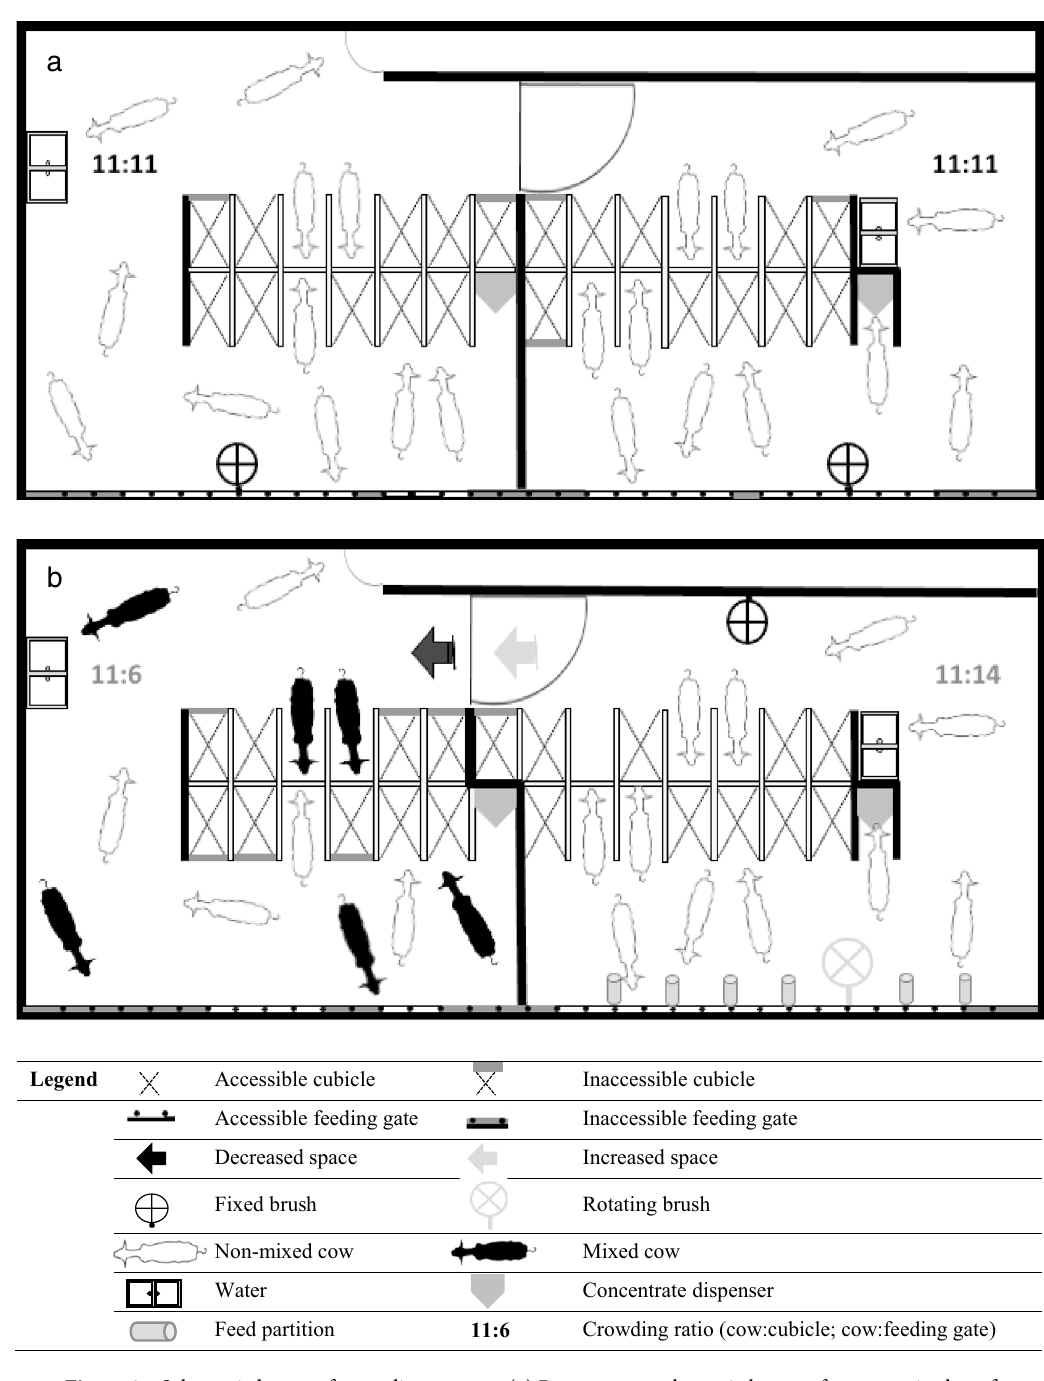
Figure 2. Schematic layout of two adjacent pens. ( a ) Represents a schematic layout of two pens in the reference conditions. ( b ) Represents a schematic layout of two pens at the end of the negative housing conditions (left pen) and at the end of the positive housing conditions (right